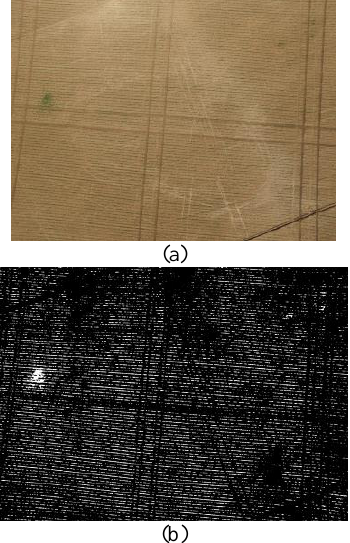
Figure 3. vegetation segmentation process result, (a) RGB image for an agriculture field, (b) the vegetation binary image.